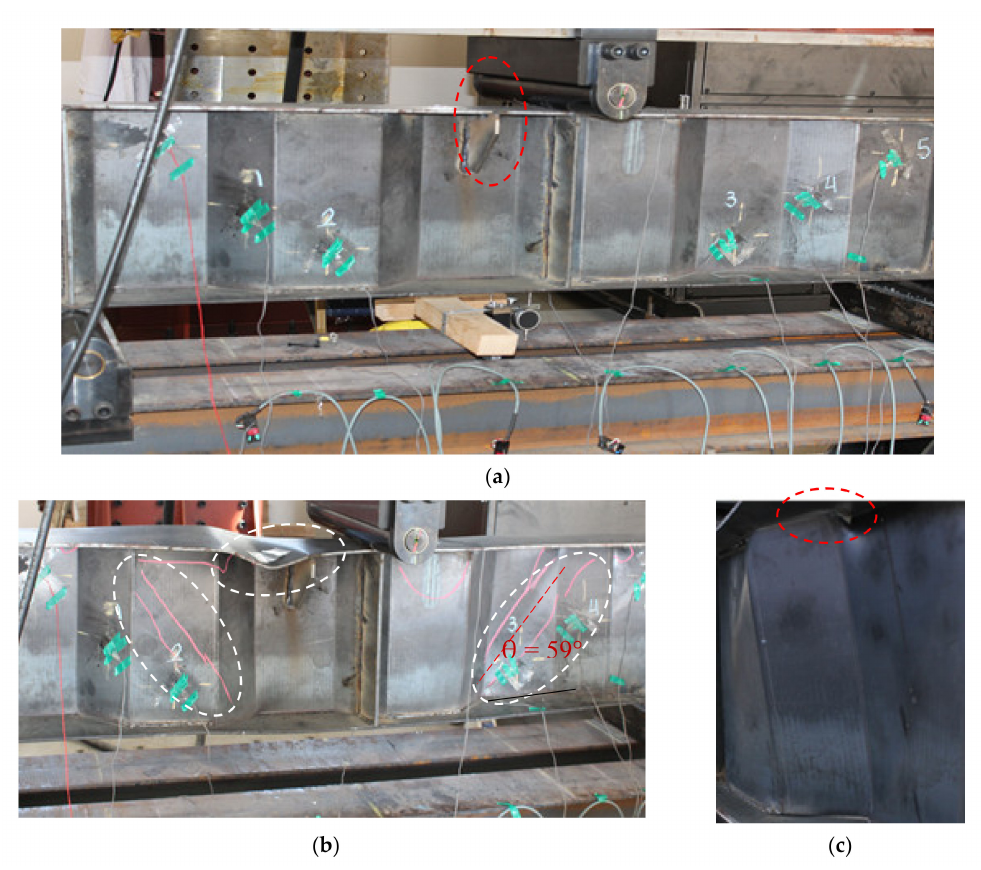
Figure 12. Details and failure mode of specimen CW20IFNWFS: ( a ) Specimen under testing; ( b ) Local web buckling and vertical flange buckling; ( c ) Web